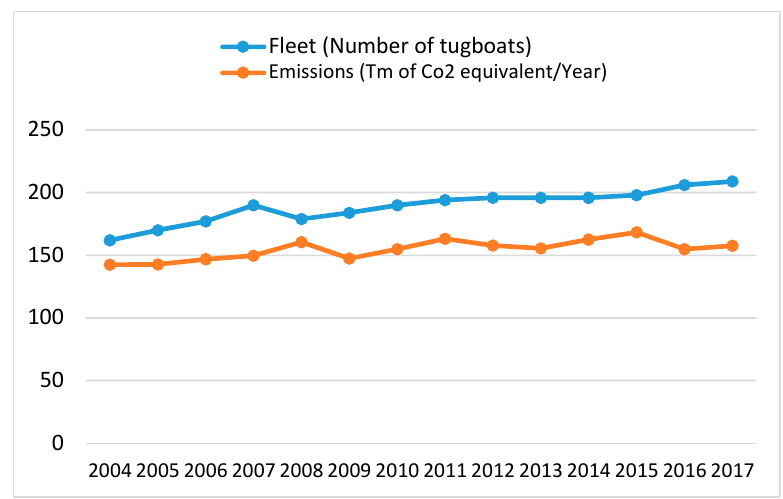
Figure 3. Evolution of the Spanish ports tugboat fleet and emissions measured. Source: Authors. Figure 4 shows the distribution of the emissions of greenhouse gases of the Spanish tugboat fleet among the ports of the different regions for the period analyzed (x-axis). The fleets of the regions of Galicia, Canary Islands, Community of Valencia and Andalusia (y- axis) have the highest values, with average values of over 3000 Tm of CO 2 equivalent.